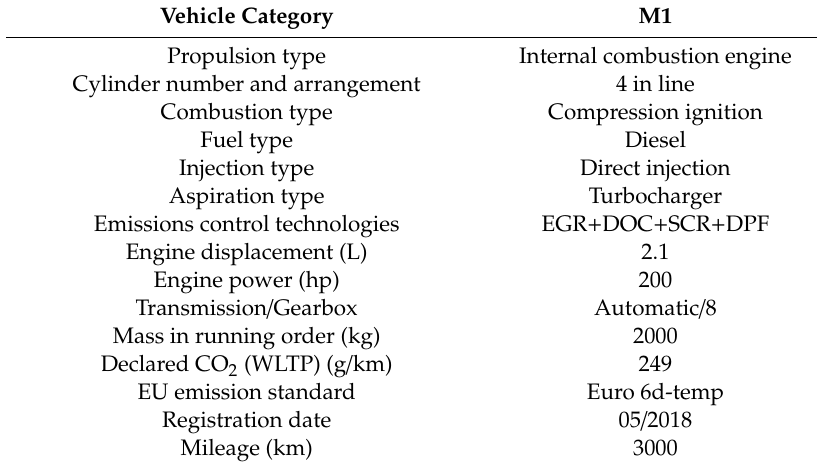
Table 1. Vehicle general